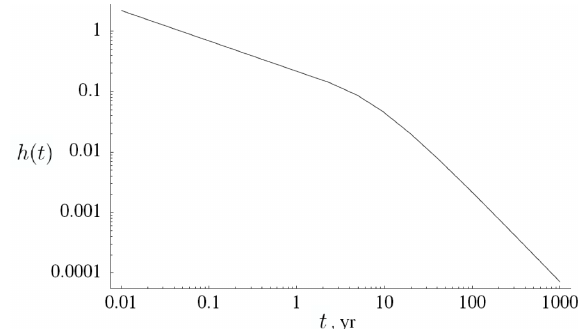
Figure 8. A log–log plot of h(t) vs. t (after Scher et al., 2002; © with permission from the American Geophysical Union